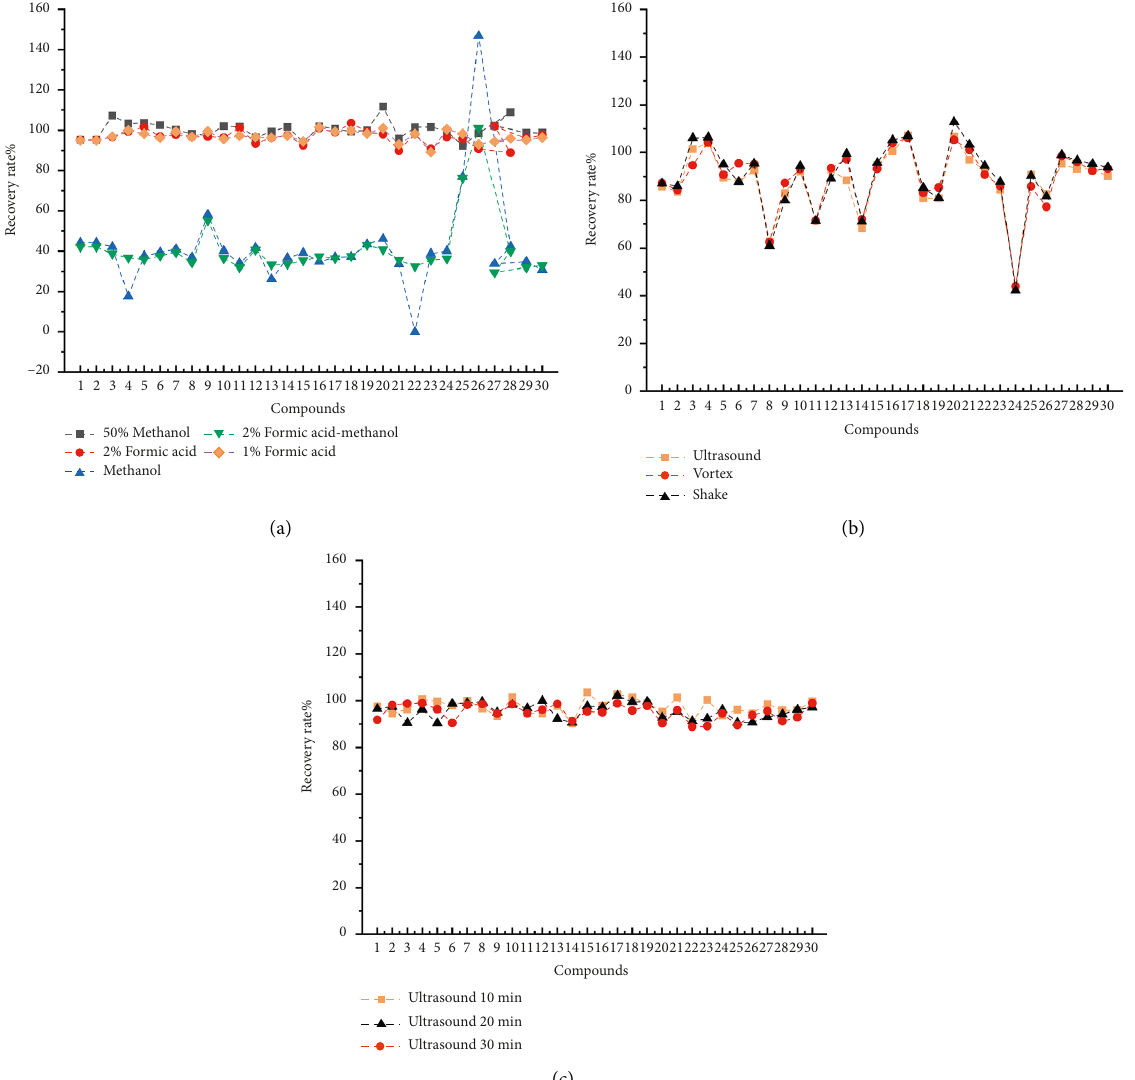
Figure 4: Xiaoyao tablet preparation extraction method, extraction time, and extraction solvent selection results. (a) Extraction solvent selection results, (b) extraction method selection results, and (c) extraction time selection results. The numbering of the 30 target analytes in Figure 4 is same as in Figure